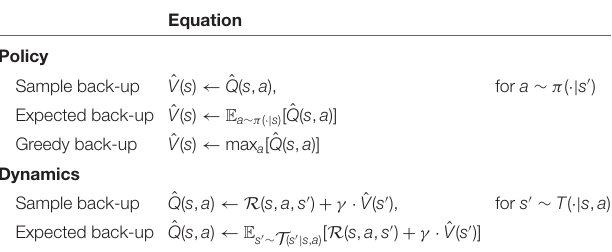
TABLE 5 | Equations for the policy and dynamics back-up, applicable to Algorithm 1 line 18 and 28, respectively.